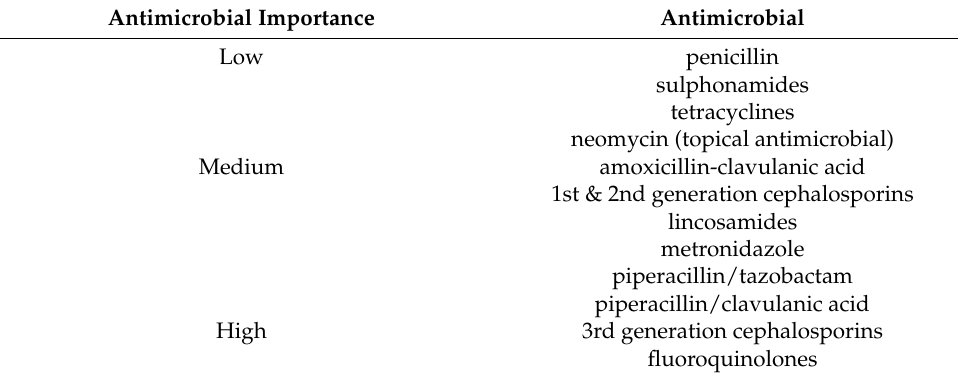
Table 6. Antimicrobial classification adapted from the Australian Strategic and Technical Advisory Group on Antimicrobial Resistance relevant to the treatment of DBW